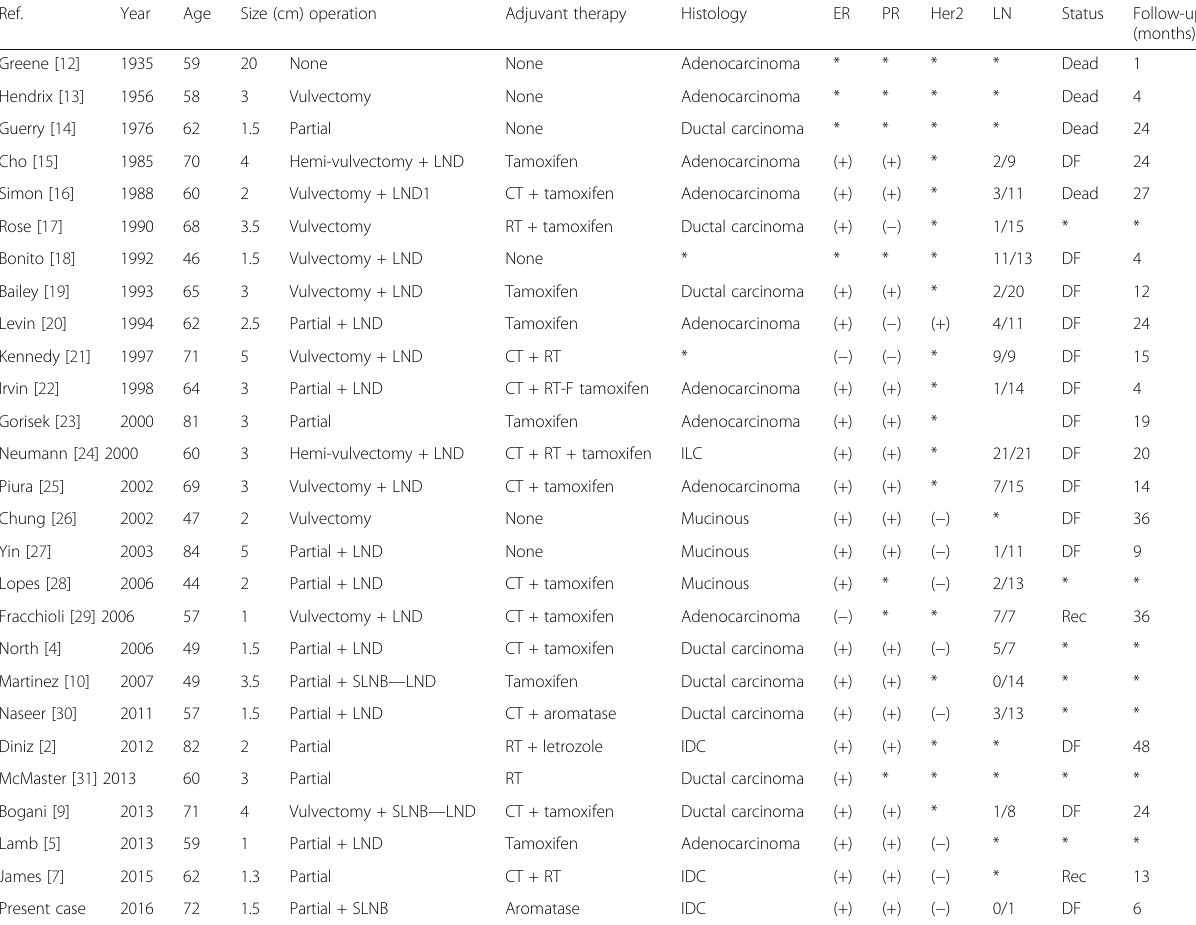
Table 1 The characteristics of primary ectopic breast carcinoma of the vulva Ref.